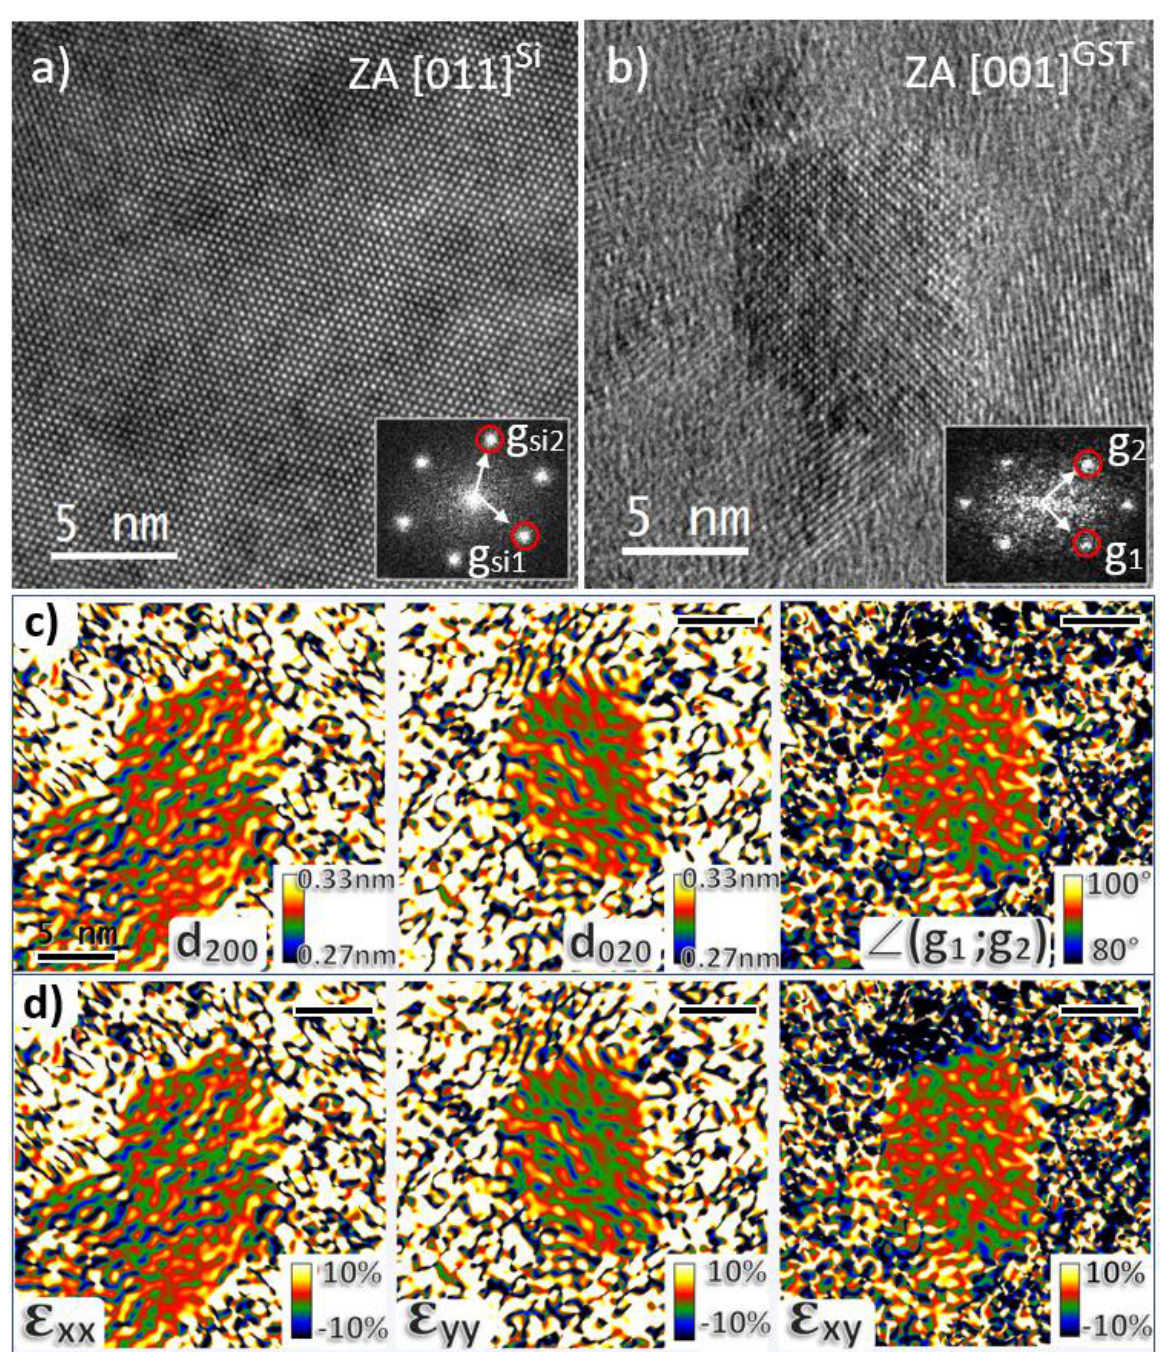
Figure 6. HR-TEM images of the reference Si lattice ( a ) and of a large Ge 2 Sb 2 Te 5 crystal viewed along the <001> GST zone axis ( b ). Inserts show their corresponding FFTs and the reciprocal vectors used for AbStrain analysis. AbStrain analysis: maps of the (200) and (020) interplanar distances and of the angle between these planes obtained after correction ( c ). Extracted strain components ε xx , ε yy and ε xy (reference is the perfect GST-225 cubic lattice) ( d ). The black scale bars refer to a length of 5 nm. The same analysis was carried out on 15 different nanocrystals located in the same region and the results are plotted in Figure 7a. The shear strain components were always close to 0 (<0.05%) and are not shown. The plots of ε xx and ε yy show that their mean values are close to zero (at about − 0.1%), and that all measured strain values are below +/ − 1%, with most of them below +/ − 0.5%, which must result from the limitations of the technique and from the actual strain states of the